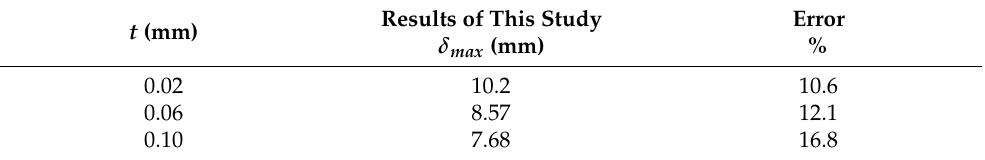
Table 1. Comparison of maximum impact depth.